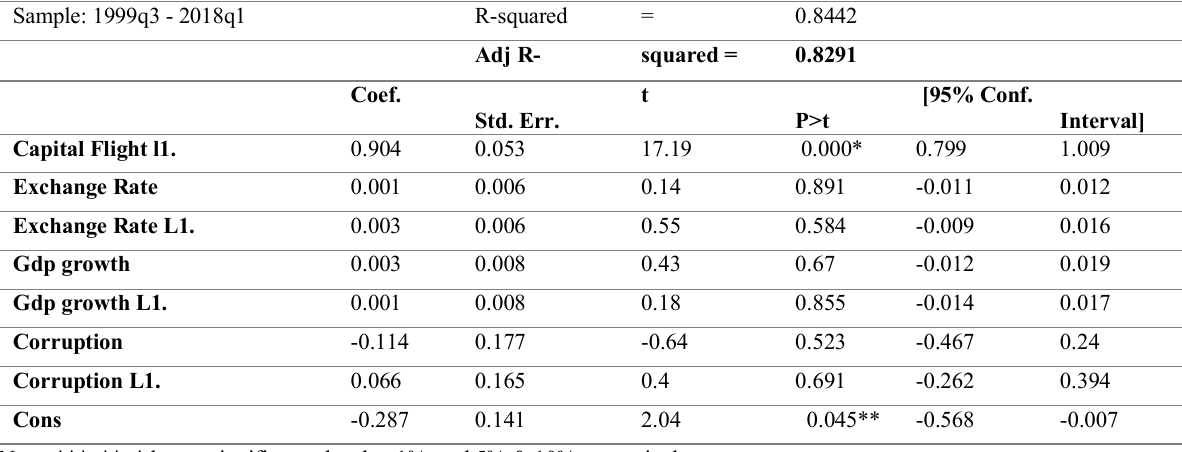
Table 6: Overall ARDL Model